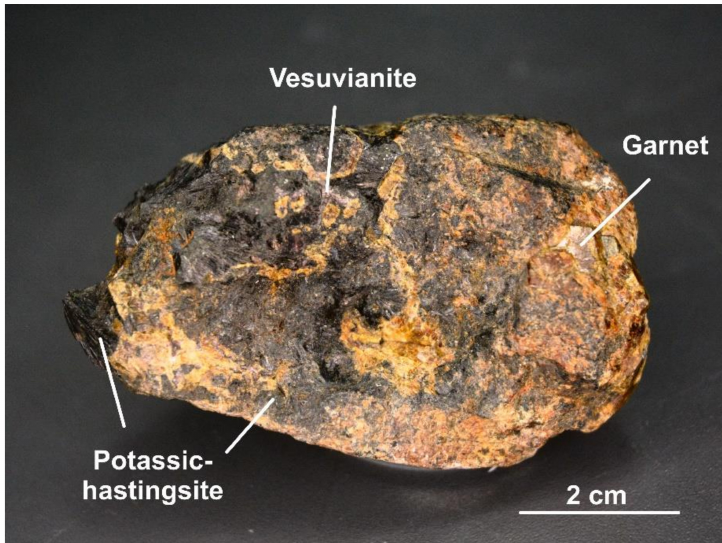
Figure 2. Skarn sample.